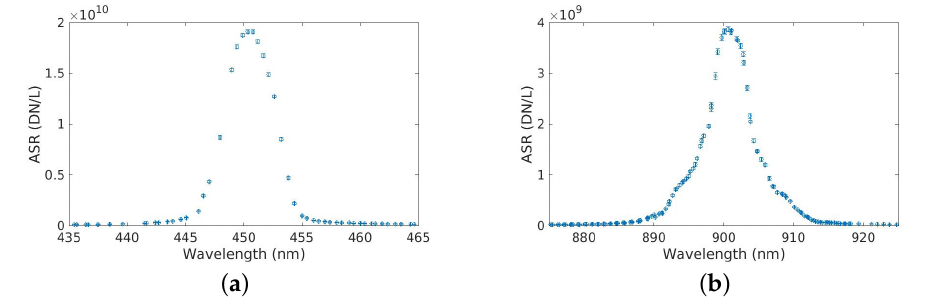
Figure 9. Sample SOLARIS ASRs for ( a ) a visible band and ( b ) an NIR